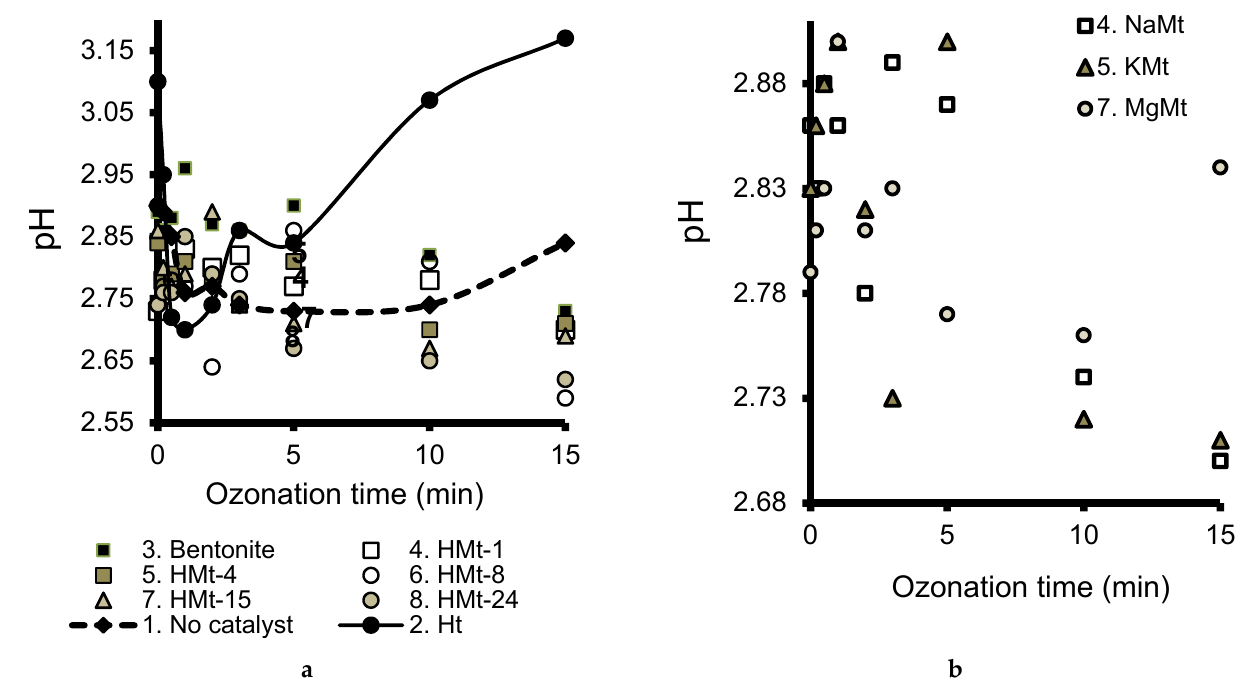
Figure 7. Evolution of the pH of the reaction mixture during LA ozonation in presence of various clay catalysts ( a ) and focus on ion-exchanged Mt samples ( b ) as compared to non-catalytic ozonation ( Curve 1-dashed line ) and hydrotalcite ( Curve 2 ).